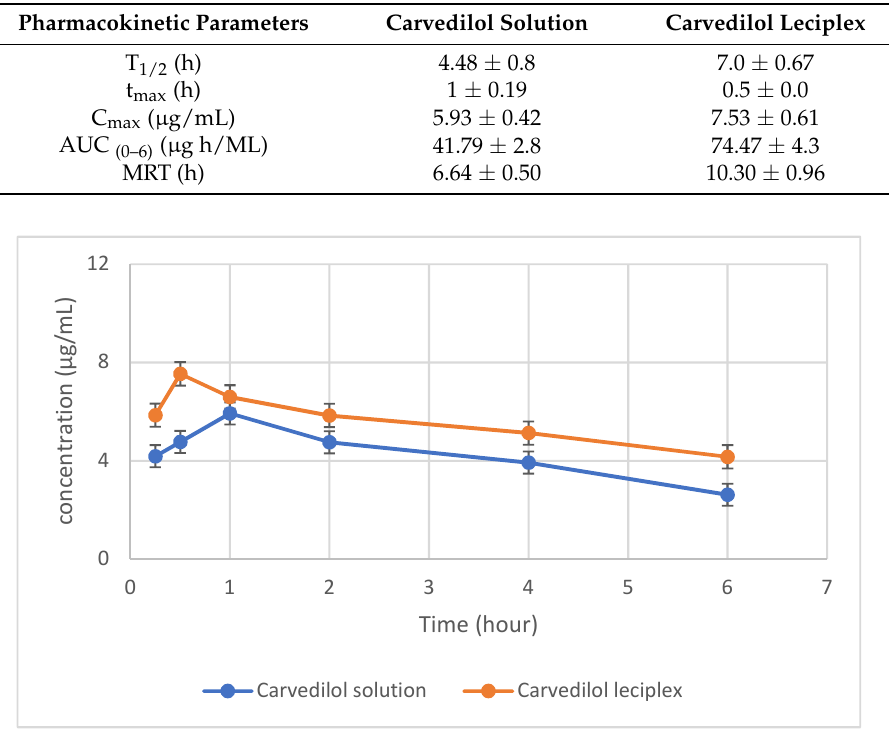
Figure 3. Concentration—time profiles of carvedilol in rabbit aqueous humor after single administration of different formulation.